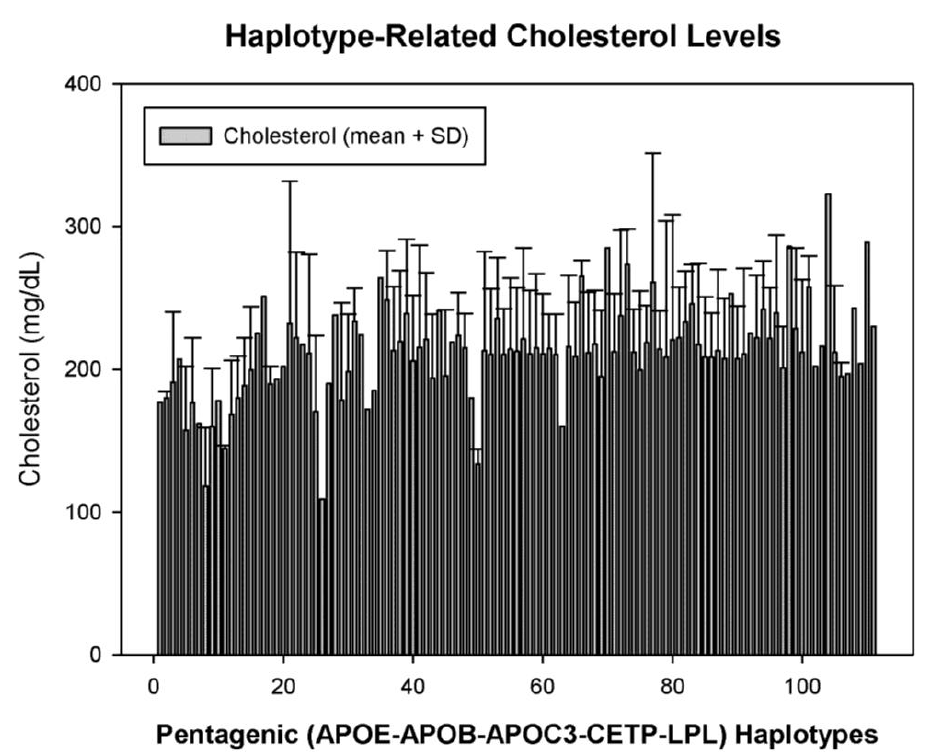
Figure 6. Pentagenic haplotype-related basal cholesterol levels in patients with Alzheimer’s disease.